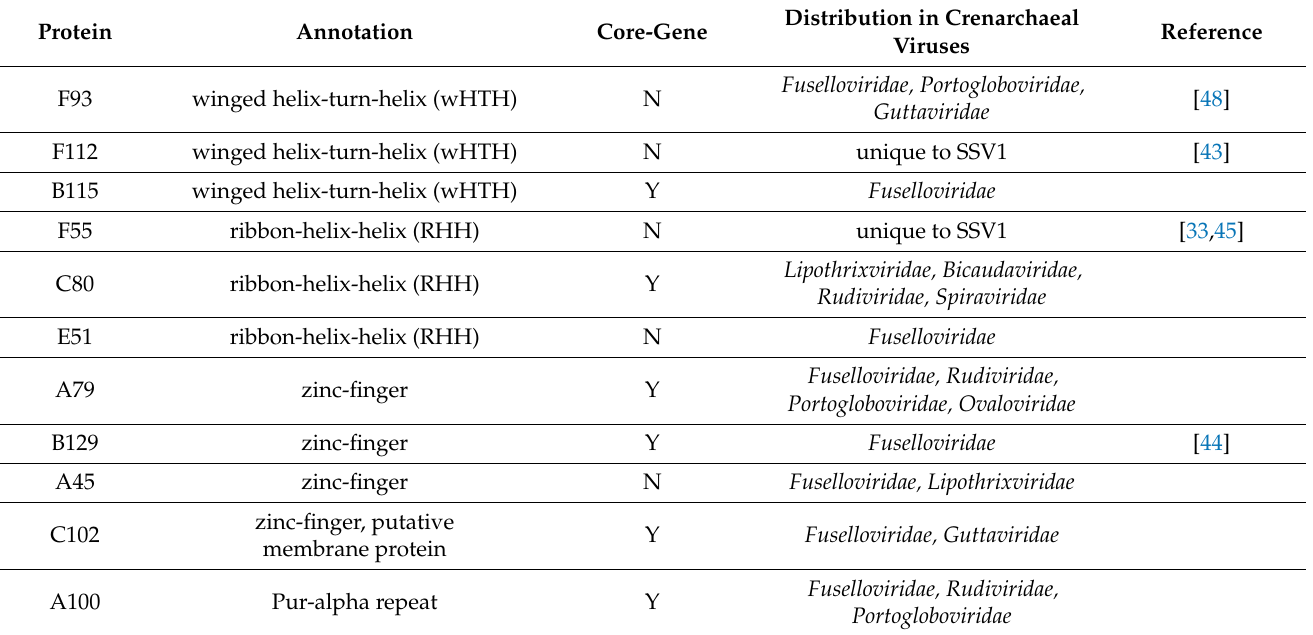
Table 1. Putative transcriptional regulators in